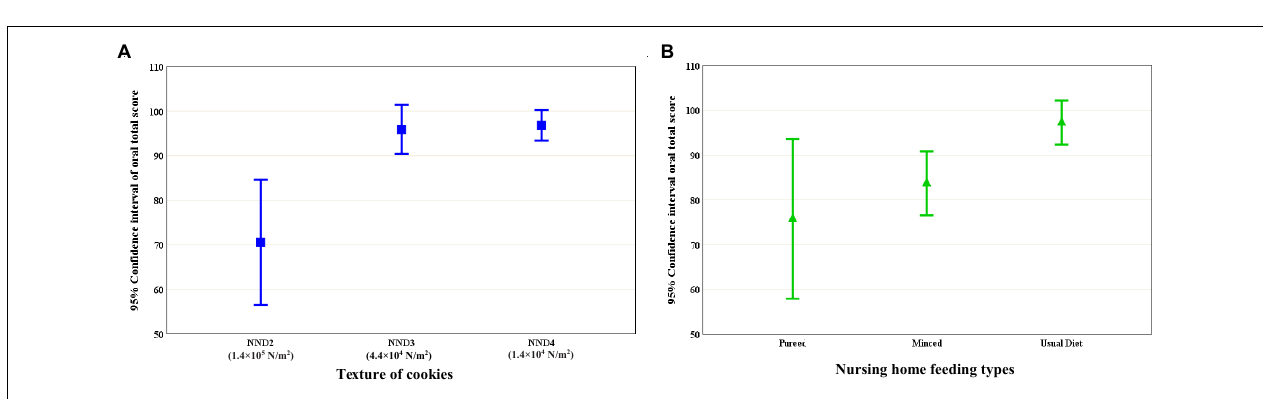
FIGURE 2 | Spearman correlations between cookie texture and nursing home feeding and oral assessments (* p < 0.05, ** p <